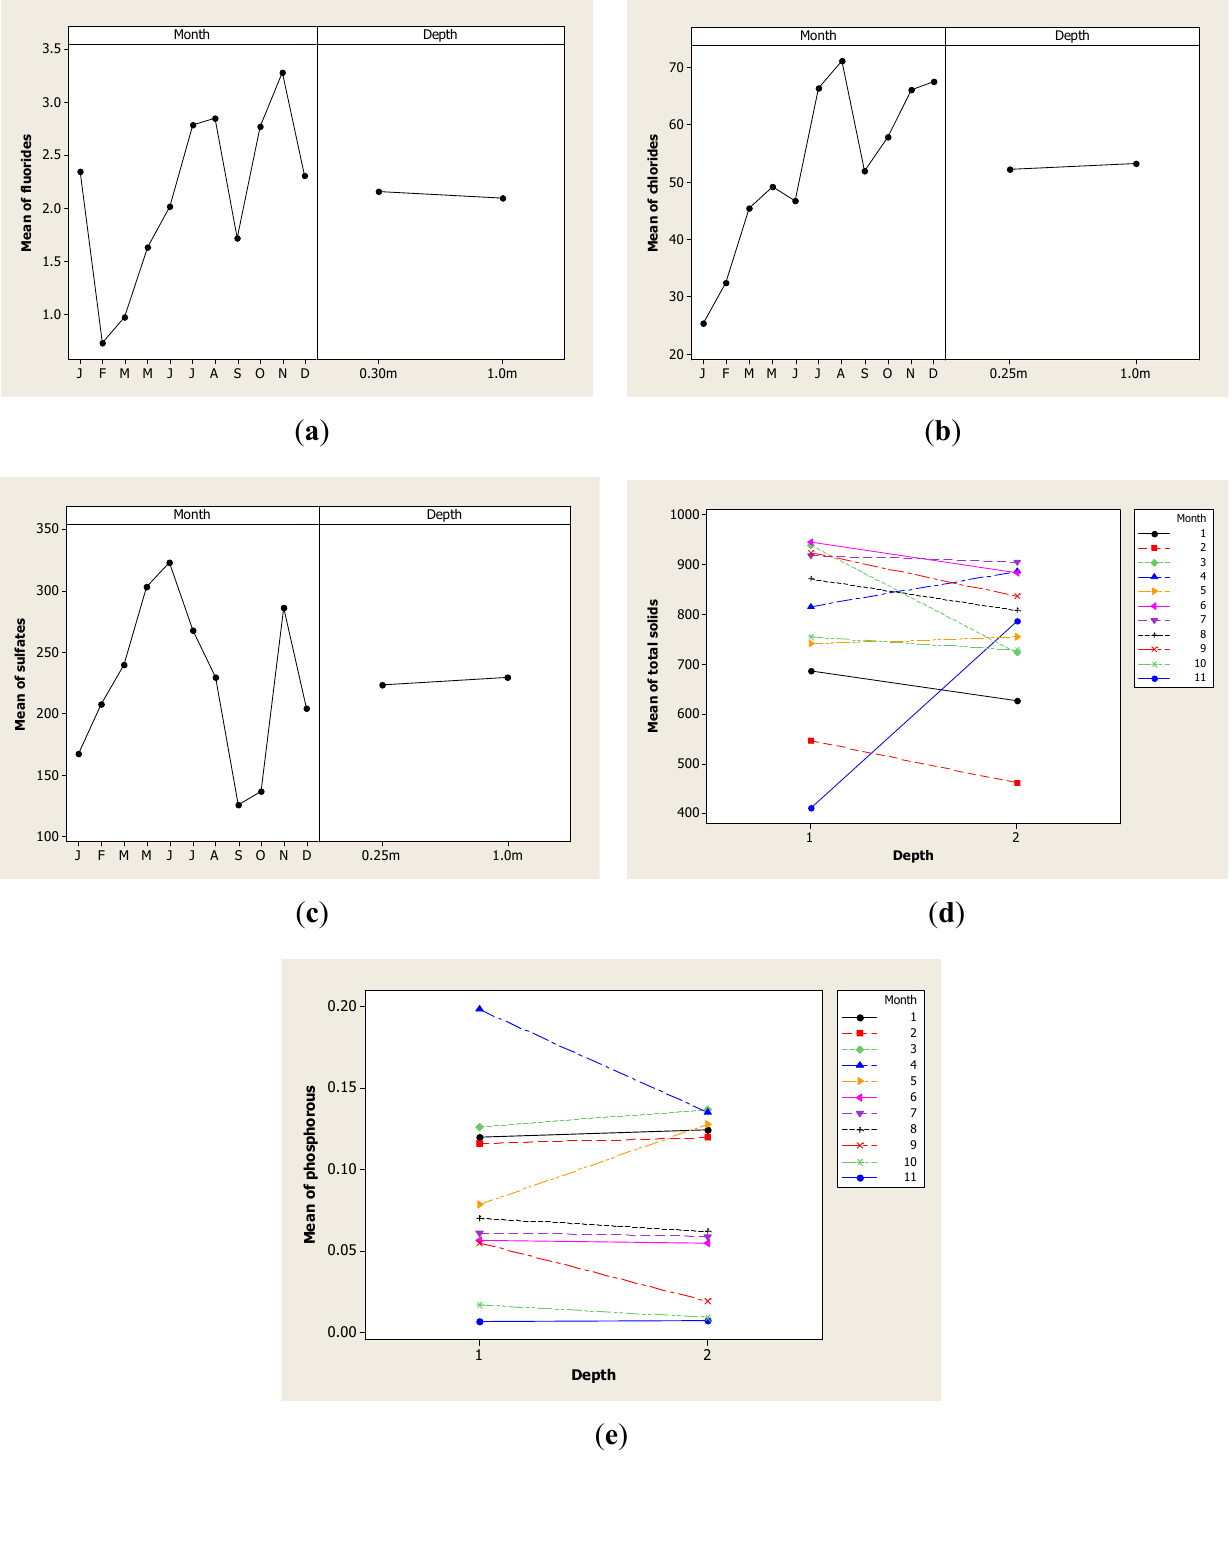
Figure 3. Parameter levels for fluorides, chlorides, sulfates, TS and P in water samples from the Luis L. Leon dam in Chihuahua,